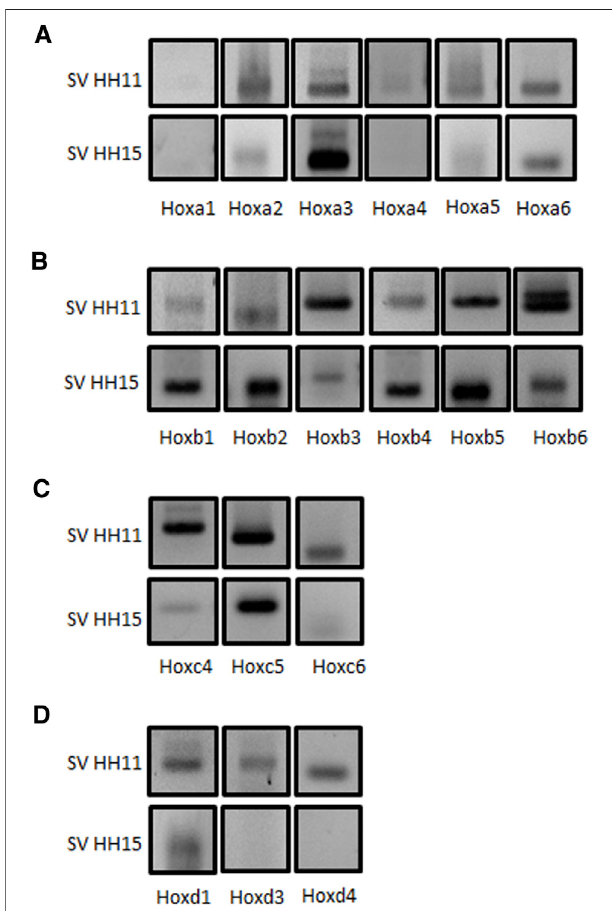
FIGURE 3 | Comparative analysis of Hox gene expression in the sinus venosus between stages HH11 and HH15. RT-PCR analyses of Hoxa (Panel